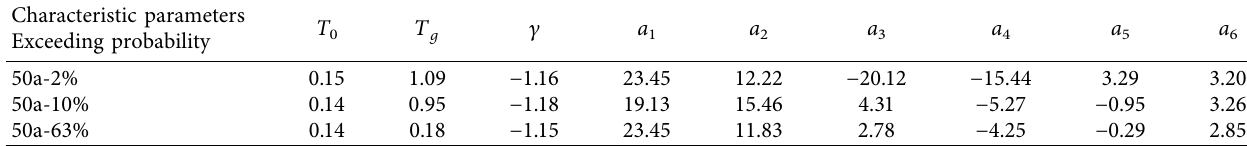
Table 10: Spectrum calibration parameter list of genetic algorithm calibration design.